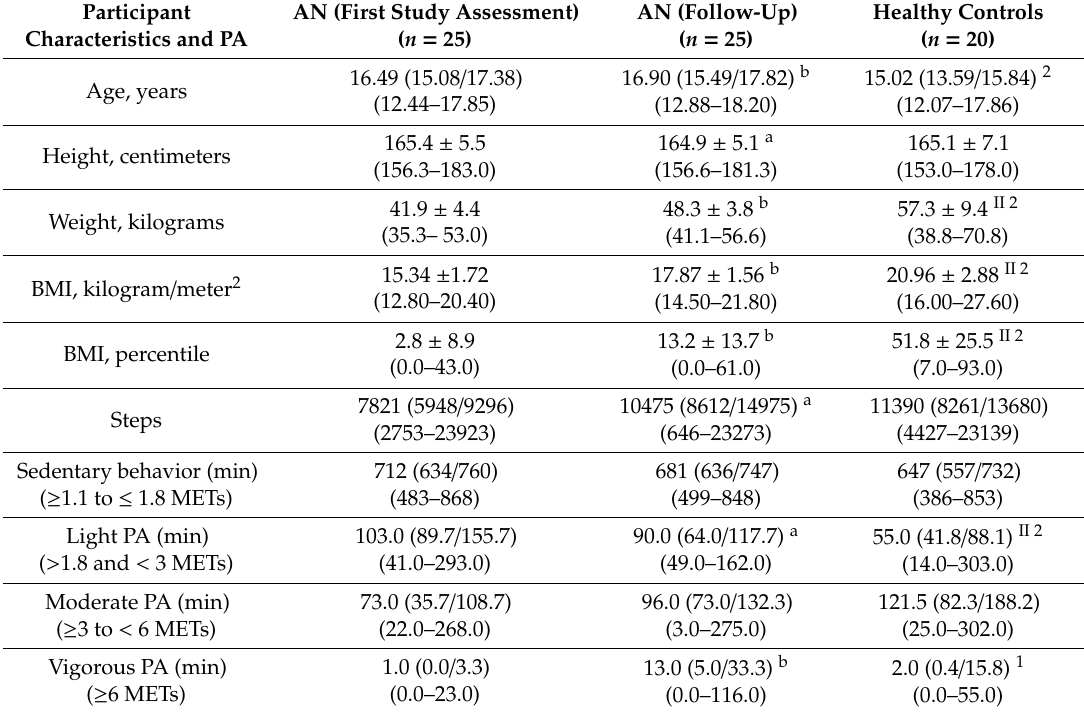
Table 2. General characteristics and PA parameters for AN patients at first study assessment, AN patients at outpatient follow-up and healthy controls ◦